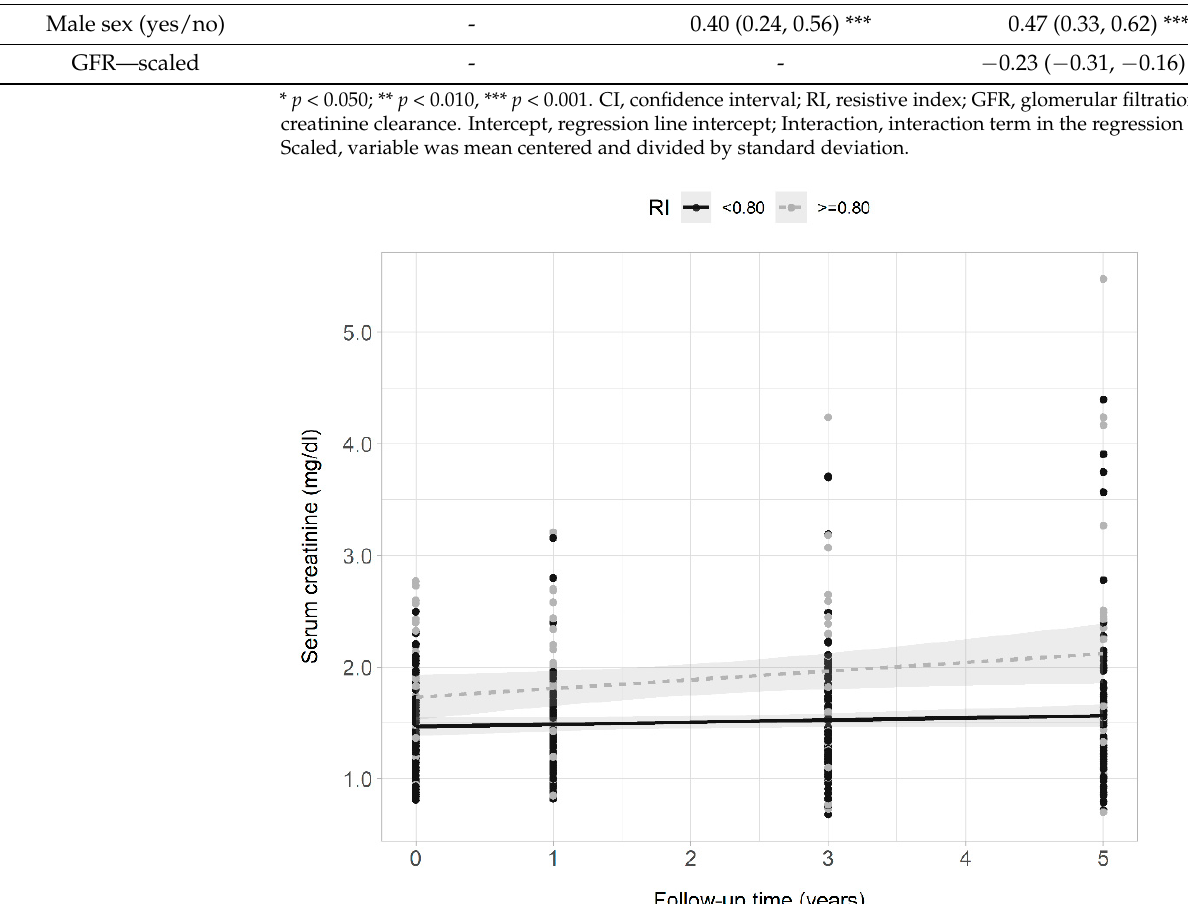
Figure 3. Scatter plots, regression lines, and 95% confidence intervals of the dependent variable serum creatinine clearance and the fixed factor time of patients with intrarenal RI ≥ 0.80 (gray points and dashed line) and <0.80 (black points and continuous line) across the 5 years of observation. Table 4. Univariate and best logistic regression model for renal disease progression assessed by at